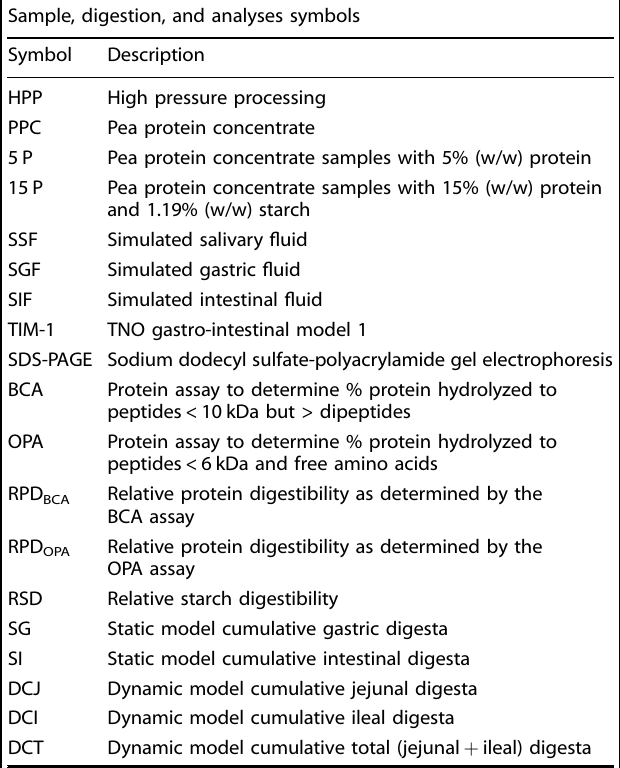
Table 1. Description of sample, digestion, and analyses symbols.